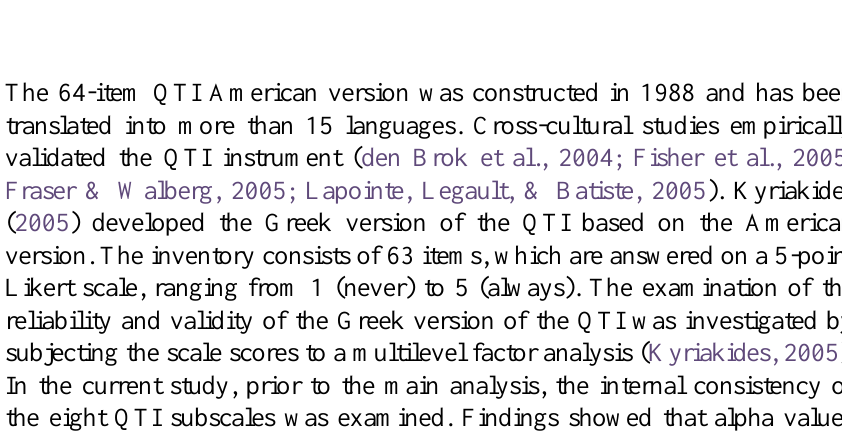
Figure 2. The Model for Interpersonal Teacher